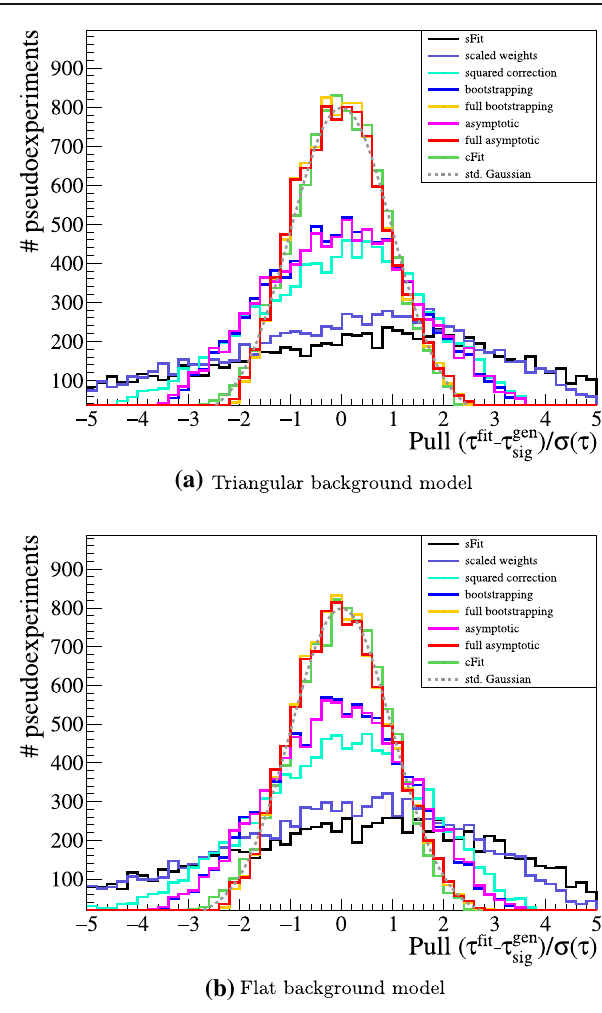
Fig. 8 Pull distributions from 10000 pseudoexperiments for the dif- ferent approaches to the uncertainty estimation for a total yield of 2000 events in each pseudoexperiment. The different figures shown corre- spond to the different background models as specified in Sect. 4